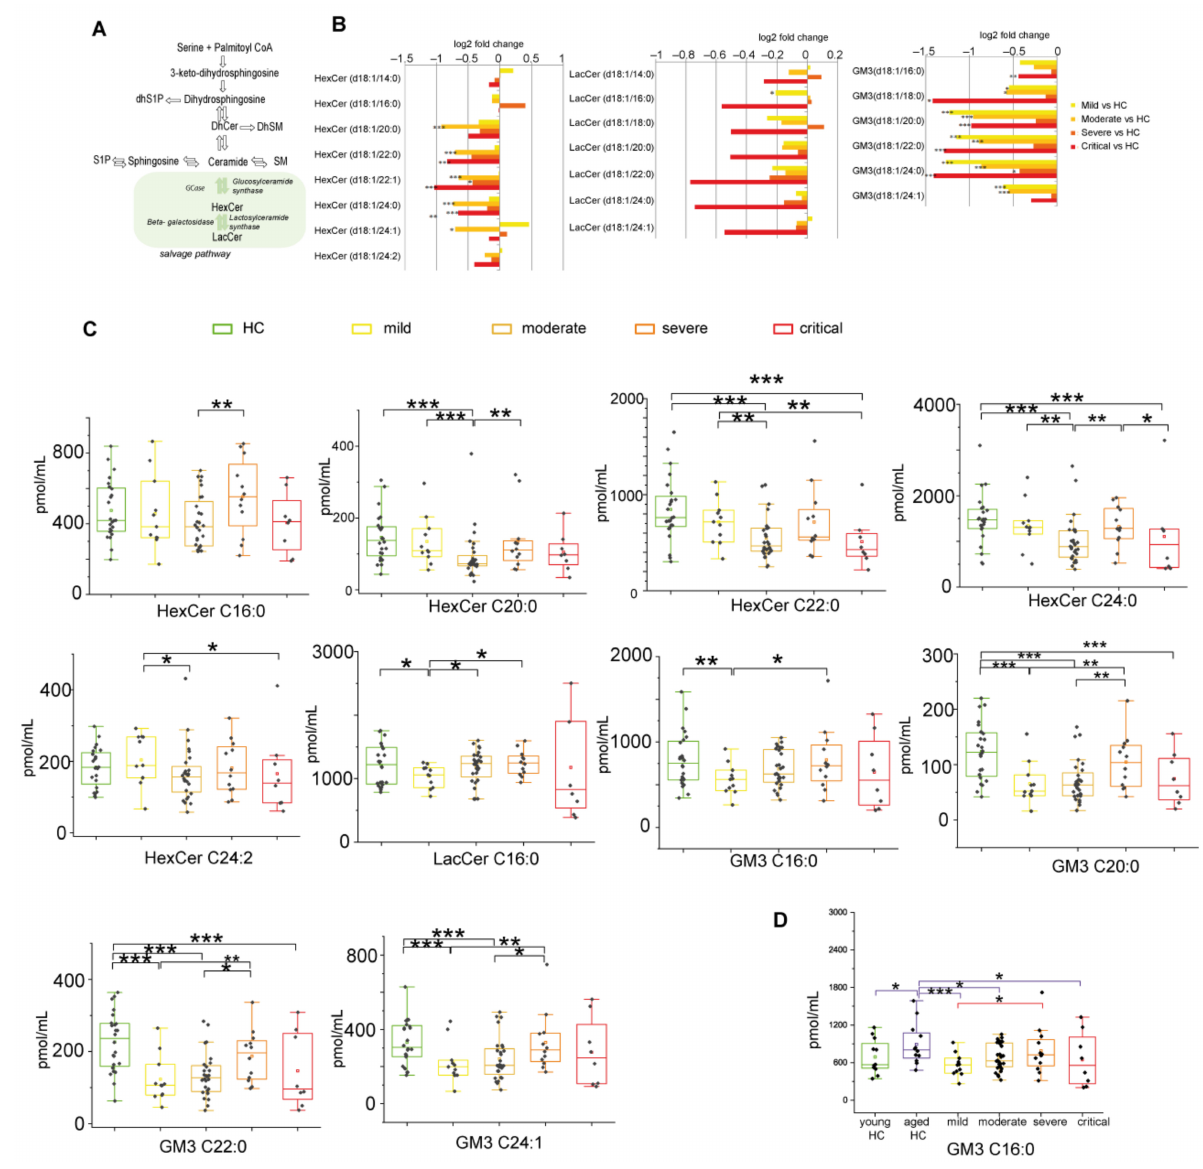
Figure 6. ( A ) Serum sphingolipid changes related to COVID-19 in the glycosphingolipid pathway, highlighted in green. ( B ) Log 2 fold changes of median values of HexCers (C14:0, C16:0, C20:0, C20:1, C22:0, C22:1, C24:0, C24:1, C24:2), LacCers (C14:0, C16:0, C18:0, C20:0, C22:0, C24:0, C24:1) and GM3s (C16:0, C18:0, C20:0, C22:0, C24:0, C24:1) in COVID-19 severity groups vs. healthy controls (HC). ( C ) Box plots of glycosphingolipid species changed according to COVID-19 severity (HexCers C16:0, C20:0, C22:0, C24:0, C24:2, LacCer C16:0, GM3s C16:0, C20:0, C22:0, C24:1). ( D ) Serum levels of GM3 C16:0 considering young HC and aged HC. Each measurement was performed in triplicate. Data were analyzed using Kruskal-Wallis ANOVA, followed by Dunn’s post hoc test for multiple comparisons. * p -value < 0.05, ** p -value < 0.01, *** p -value <